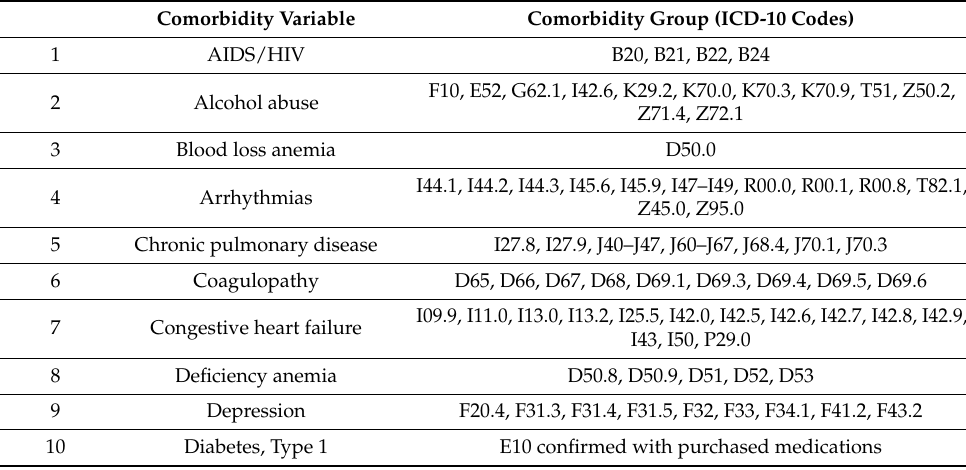
Table A2. Medical history of subjects waited for CTs in Poland during